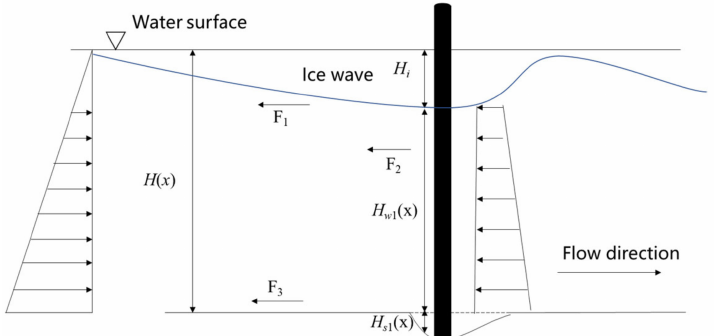
Figure 4. Forces acting on the control volume of flowing water under an ice wave around the bridge pier.